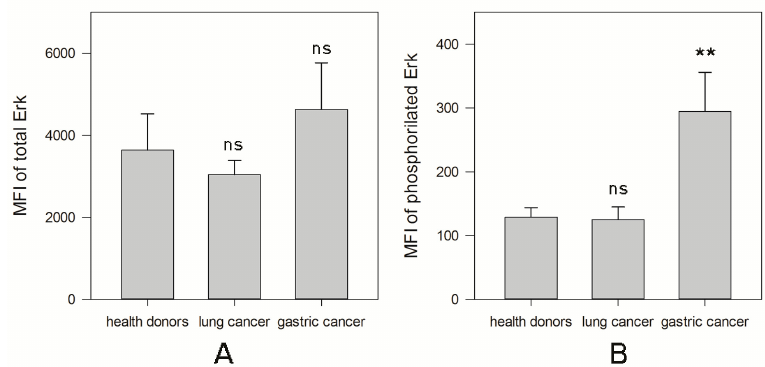
Figure 3. Differences in the total and phosphorylated level of ERK in NK cells harvested from healthy donors and cancer patients. NK cells were isolated from the peripheral blood samples by negative selection using Dynabeads. The total and phosphorylated levels of ERK were determined as described in M&M. ( A ) Data of MFI of total levels of ERK are shown as the mean ± SEM. ( B ) Data of MFI of phosphorylated levels of ERK are shown as the mean ± SEM. (** p < 0.01).